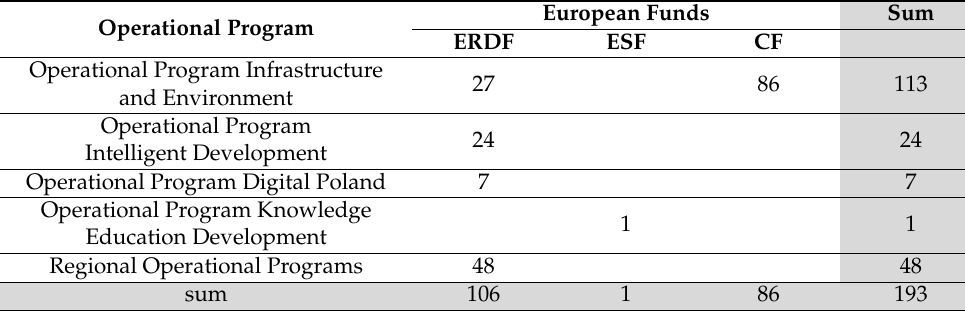
Table 3. Sources of project funding.